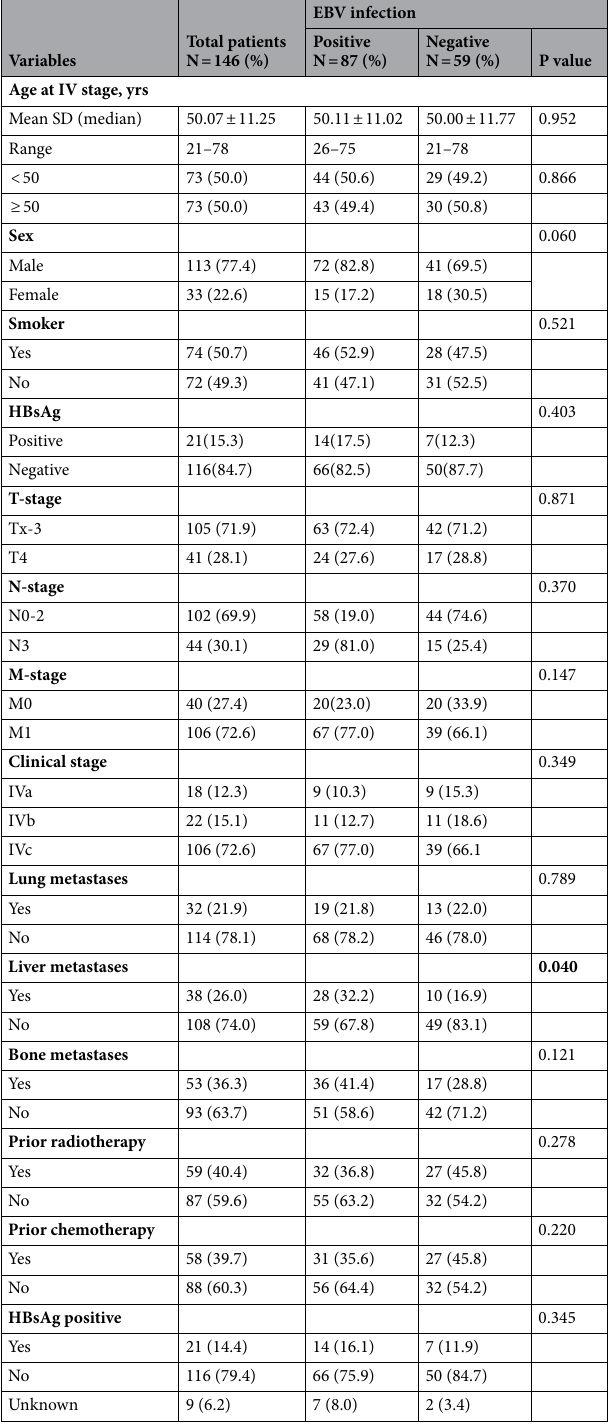
Table 1. Characteristics of patients with advanced nasopharyngeal carcinoma according to EBV